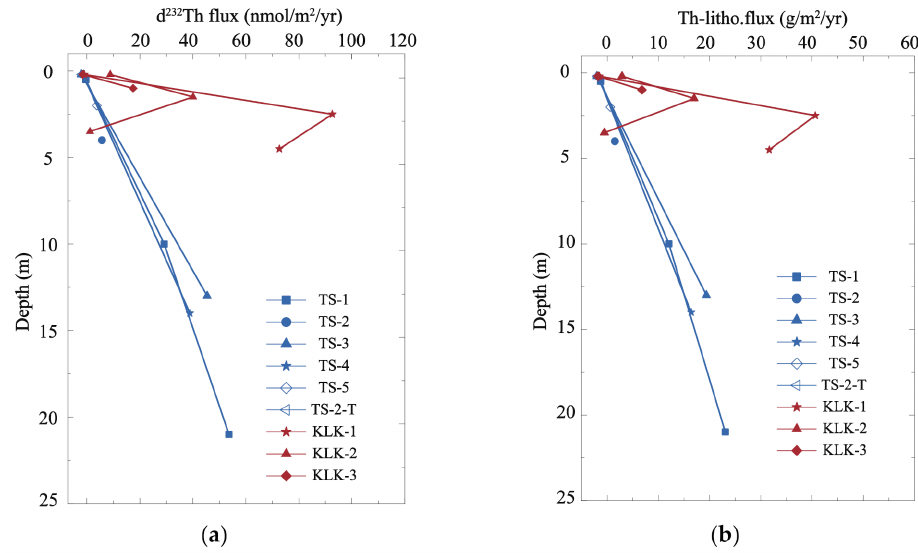
Figure 8. Distribution features of dissolved 232 Th flux ( a ) and lithogenic flux ( b ) in the depth profiles of Tuosu Lake and Keluke